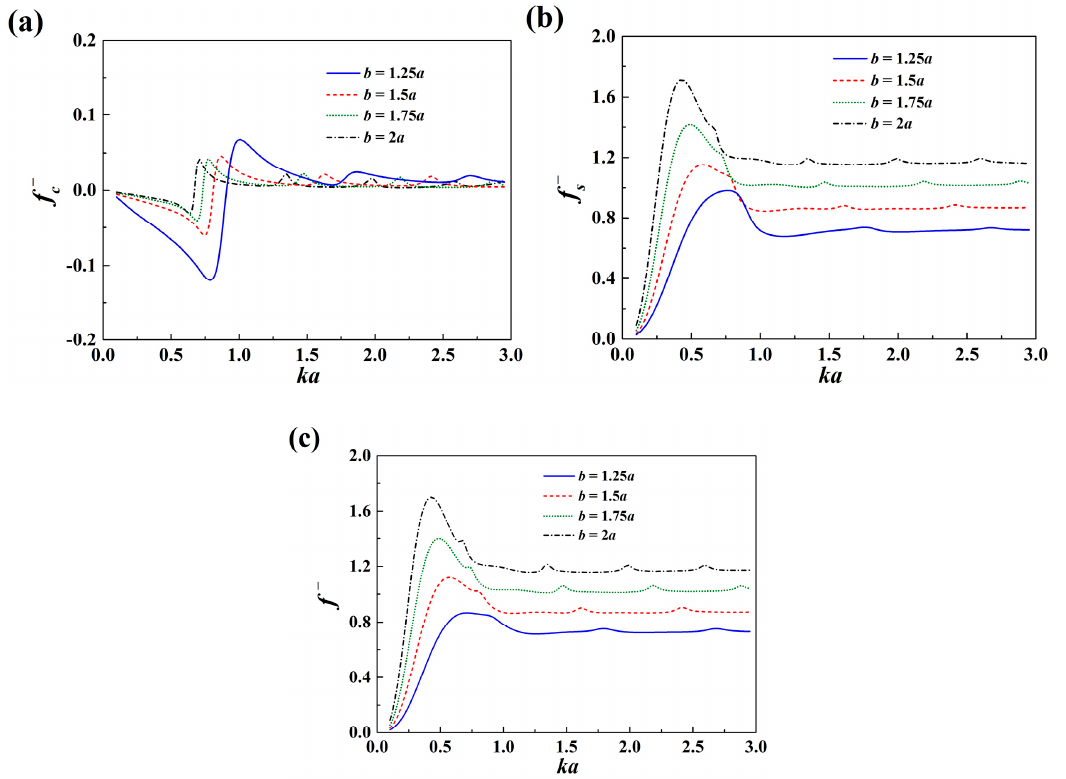
Figure 4. E ff ect of the radius of the exterior porous shell on the mean drift wave force on the interior column, the exterior porous shell, and the system ( G 0 = 0.05 and d = 3 a ): ( a ) f − c ( b ) f − s ( c ) f −